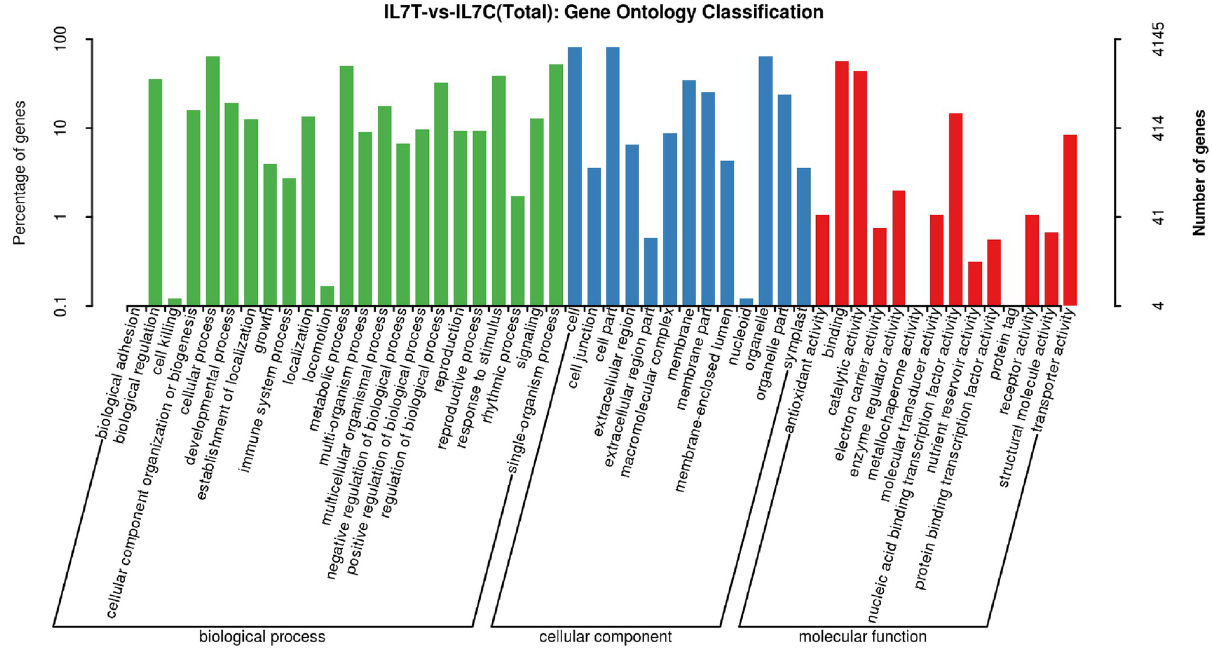
Fig 3. Functional classification of C . maxima unigenes by using Gene Ontology (GO).